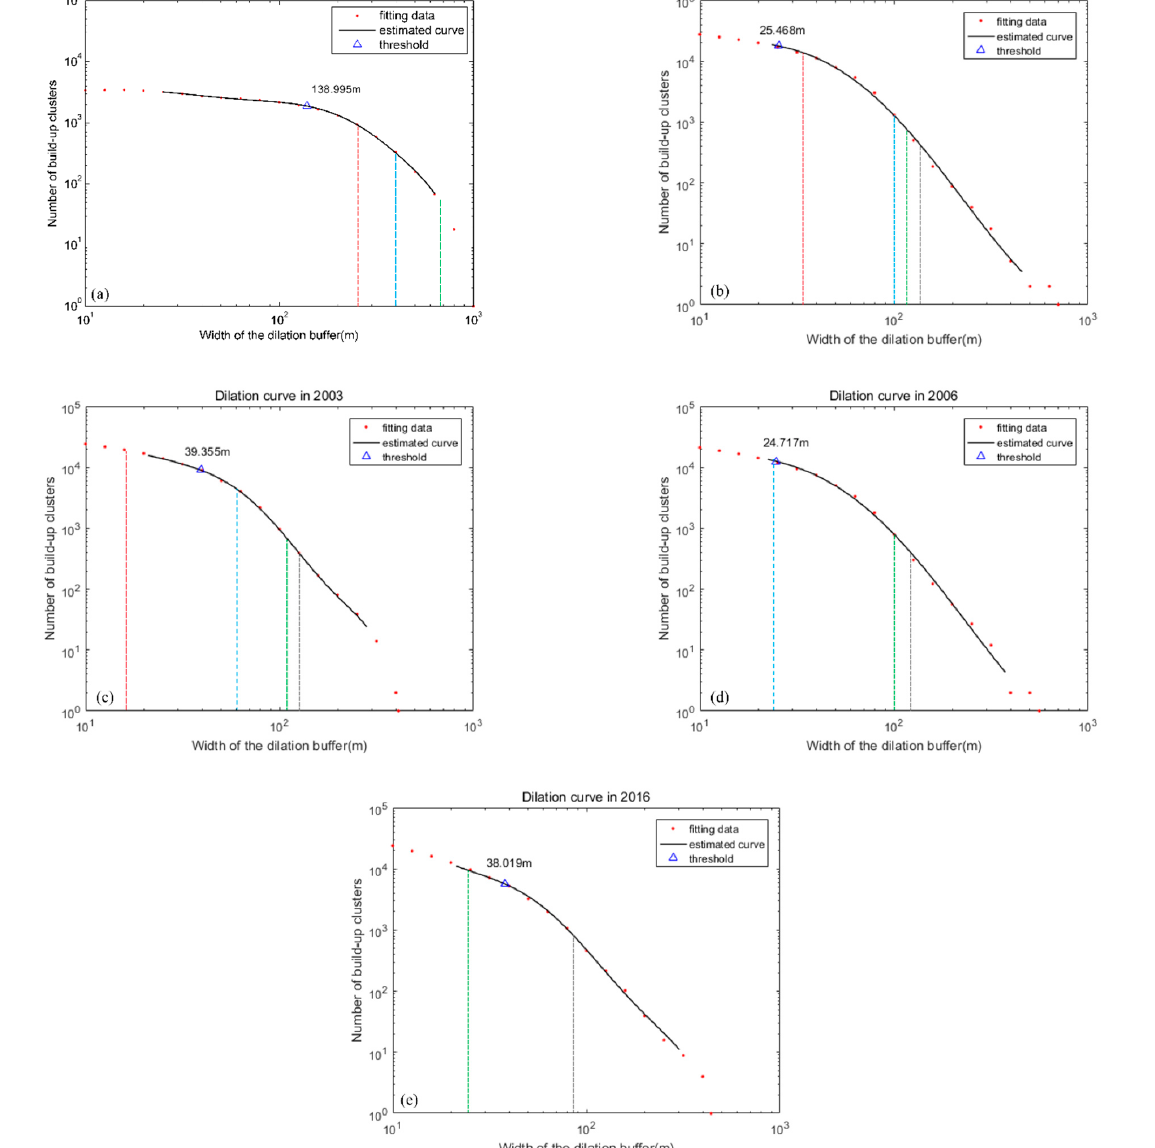
Figure 7. Results of dilation curve ( a – e ) from 1994 to 2016. The red, blue, green and gray dotted lines represent 40%, 50%, 60%, and 70% of urban coverage, respectively.